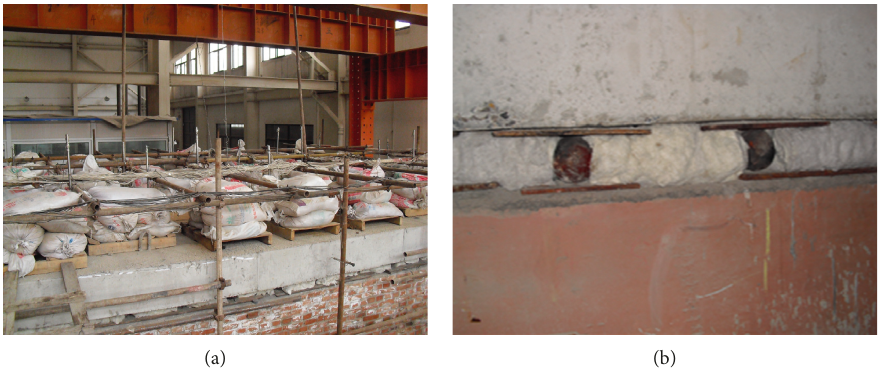
Figure 3: View of the loading. (a) Sandbags. (b) Supports.